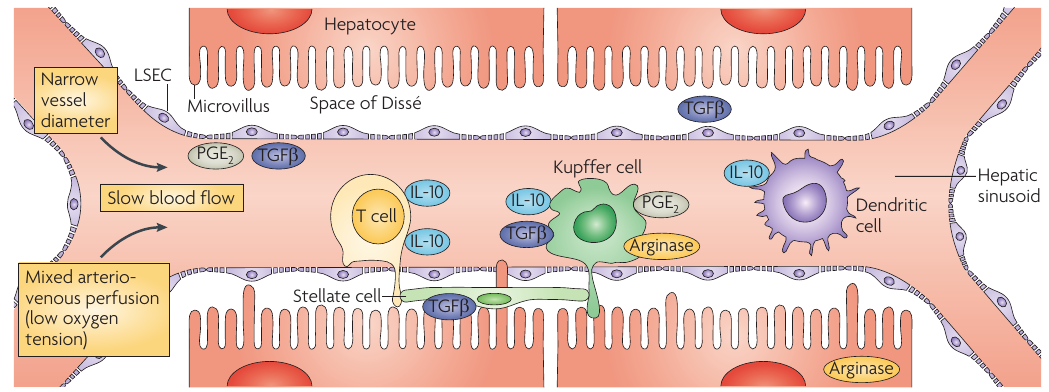
Figure 1. Anatomical location of hepatic antigen-presenting cells (APCs) and the factors that regulate their function. Branches of the hepatic artery merge with sinusoidal vessels carrying blood from the portal vein in the liver, resulting in a mixed arterio-venous perfusion of the liver with low oxygen tension. Owing to extensive branching of portal vessels into liver sinusoids, and the accompanying increase in cumulative vessel diameter, the hepatic microcirculation is characterized by low pressure and slow, sometimes irregular, blood flow. Together with the narrow diameter of hepatic sinusoids, this facilitates the interaction of circulating leukocytes with hepatic sinusoidal cell populations. The hepatic sinusoids are lined by a population of microvascular liver sinusoidal endothelial cells (LSECs) that separate hepatocytes and hepatic stellate cells (HSCs) (all of which function as APCs) from leukocytes circulating through the liver in the blood. Fenestrations in the LSEC lining allow the passive exchange of molecules between the Space of Diss é and the blood, as well as direct contact of lymphocyte filopodia with hepatocyte microvilli. The liver interstitium is highly enriched in cells of the innate immune system (such as antigen-presenting DCs, KCs, NK and NKT cells, and in T cells, which participate in adaptive immune responses. Mediators produced by both parenchymal and non-parenchymal cells, including interleukin-10 (IL-10), transforming growth factor- β (TGF β ), arginase, and prostaglandin E 2 (PGE 2 ), regulate immune function within the liver. Reprinted with permission from NPG